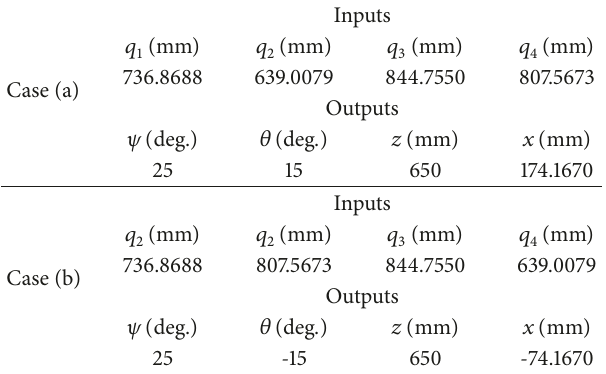
Table 2: Mechanism analysis of the forward